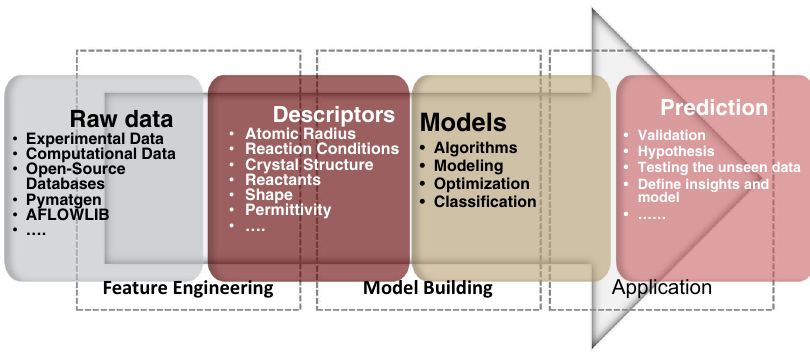
Fig. 2 Stages of AI-based ISM discovery. The main descriptors should be selected from the raw datasets. This step is performed using feature engineering. Data screening, determination of input, output and, communicated descriptors are done in this step. After that, AI can train models that can predict the performance of different ISMs. The accuracy and reliability of the model are crucially dependent on feature engineering.